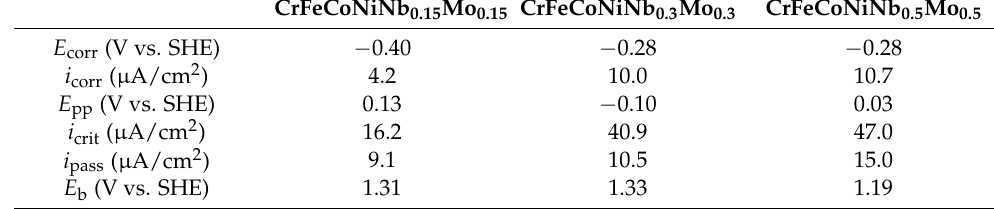
Figure 5. Potentiodynamic polarization curves of as-cast CrFeCoNiNb x Mo x alloys tested in the 1 M deaerated sodium chloric solution at 30 ° C. Table 5. Potentiodynamic polarization data of the as-cast CrFeCoNiNb x Mo x alloys in 1 M deaerated NaCl solution at 30 ° C.